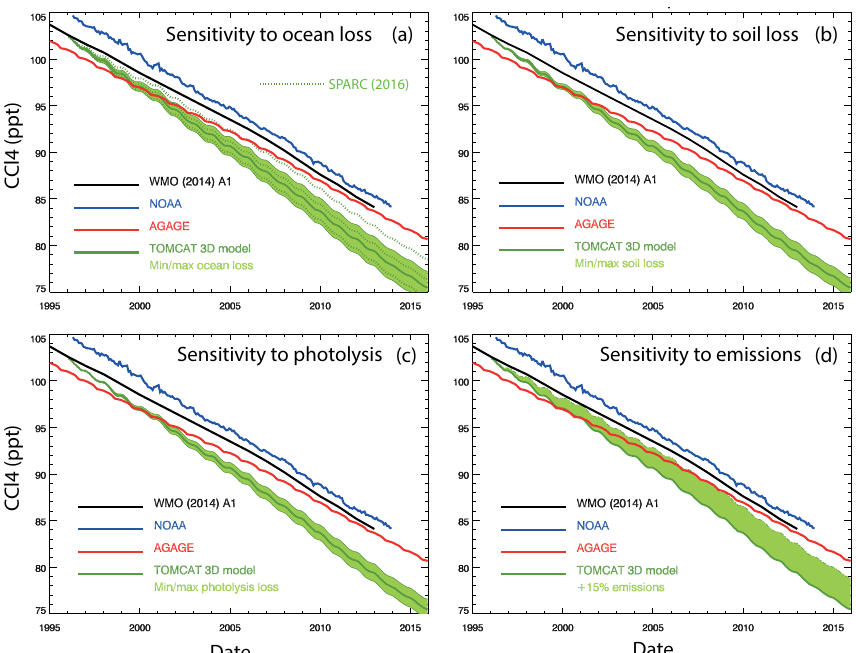
Figure 8. Observed global mean surface CCl 4 from AGAGE (red) and NOAA (blue) networks, along with merged observational dataset from WMO (2014) scenario A1 (black line). These are compared with results from TOMCAT model run CTC1 (dark green line) and different sensitivity tracers in each panel with the range given as a light green band: (a) an ocean sink of 147 (tracer CTC2) and 241 (CTC3) years, (b) a soil sink of 288 (CTC4) and 536 (CTC5) years, (c) a ± 10% change in stratospheric photolysis (CTC6 and CTC7) and (d) a 15% increase in emissions (CTC8). Note that in (d) the light green shading only shows an increase relative to control tracer CTC1 as the sensitivity tracer considered had increased emissions. Panel (a) also includes results from TOMCAT tracers which use the SPARC (2016) value for the ocean sink of 183 (CTC1s) years and the uncertainty range of 157 (CTC2s)–313 (CTC3s) years (green dashed